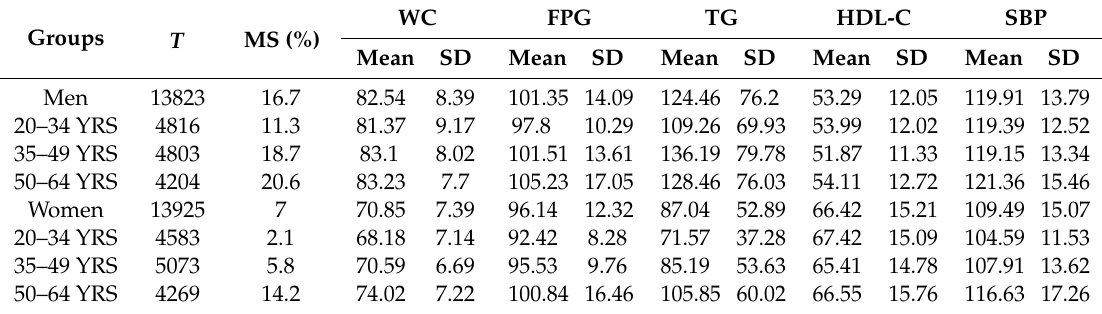
Table 2. Model fit indices and factor loadings used in the confirmatory factor analysis of sex- and age-specific groups